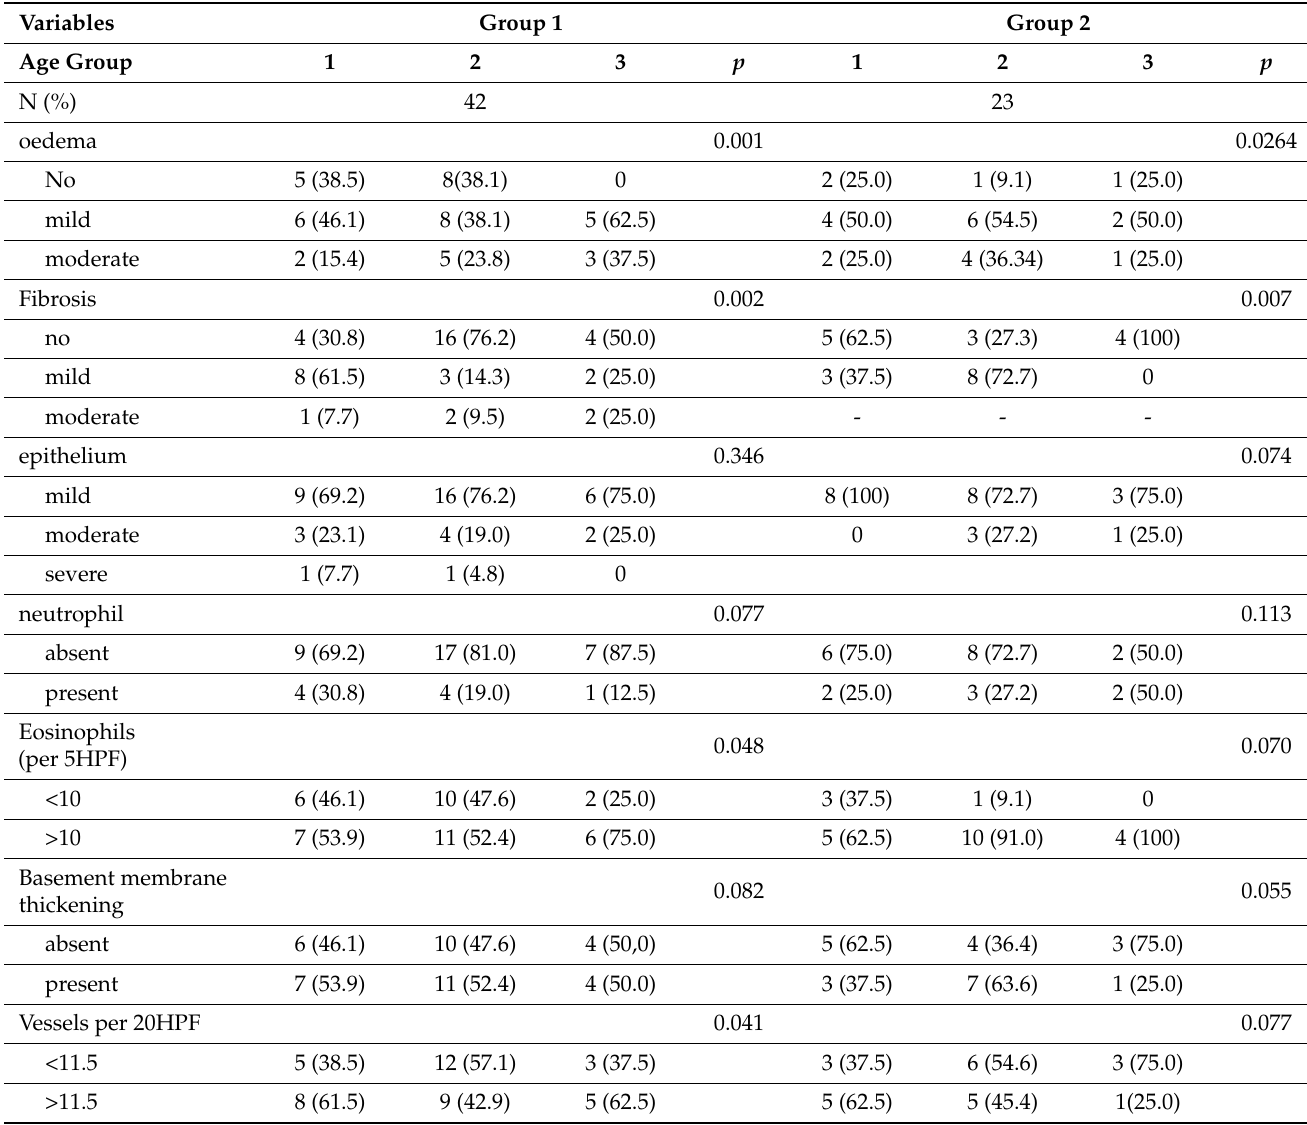
Table 3. Tissue remodeling in particular age